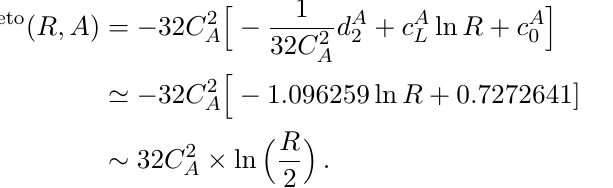
Figure 1 . Approximations of d veto plotted in red. The approximation retaining only constant terms and logarithms of R is shown in blue. The approximation retaining constant terms and logarithms of R and R 2 terms is shown in green. The leading color ansatz, eq. (2.19), derived setting n magenta. The red, blue and green curves are all plotted for n